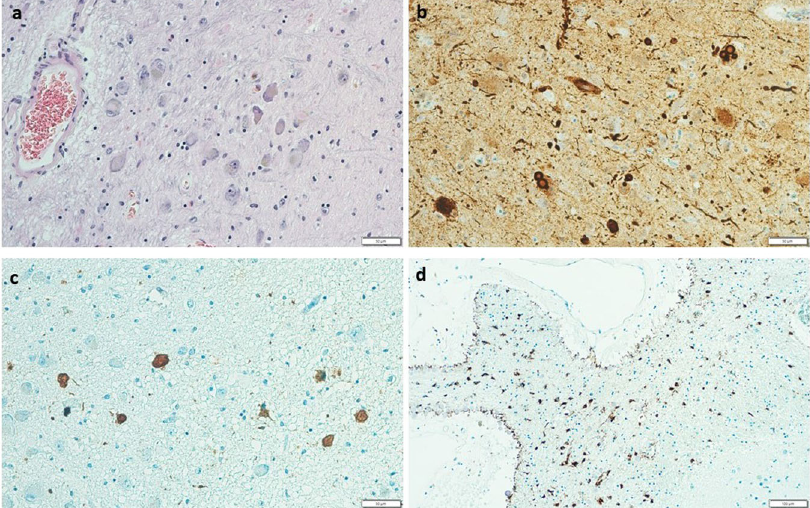
Fig. 2 “ Double-pathology “ : α -synucleinopathy + tauopathy in Parkinson ’ s disease dementia (PDD) phenotype. a Lewy body and pale bodies in pontine raphe nucleus, HE staining, original magni fi cation ×200. b Pathological deposits of α -synuclein in pontine raphe nucleus — Lewy bodies, granular cytoplasmic positivity, dystrophic neurites, and dots, stained with a monoclonal antibody against α -synuclein, original magni fi cation ×200. c Pathological deposits of tau protein in pontine raphe nucleus — tangles, pretangles, grains, and threads, stained with a monoclonal antibody against hyperphosphorylated tau, original magni fi cation ×200. d Pathological deposits of tau protein in basal ganglia associated with cribrous state — tau-astrogliopathy (ARTAG), stained with a monoclonal antibody against hyperphosphorylated tau, original magni fi cation ×100.